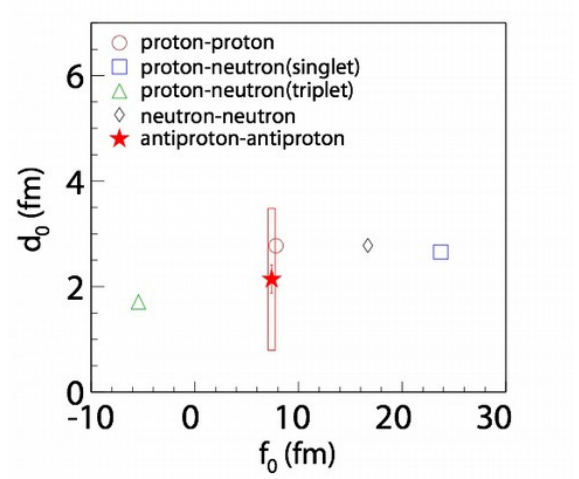
Figure 2. Parameters of strong interactions for di ff erent hadron pairs. [5]